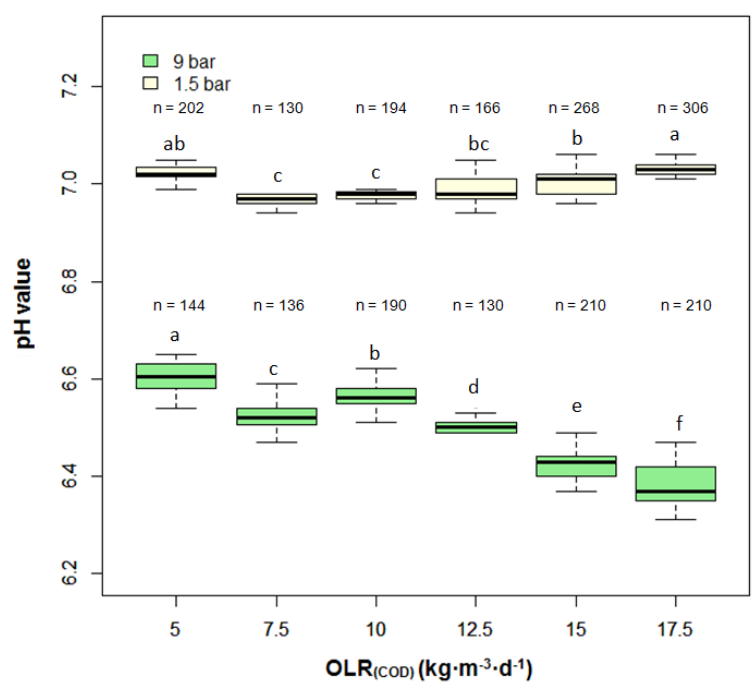
Figure 5. pH value of the pressurized anaerobic filter at different OLR and pressure levels. The box plot is characterized with the minimum, low quartile, median, upper quartile and maximum value. Significant differences among the OLR levels are marked with different letters ( p < 0.05, LSD test).